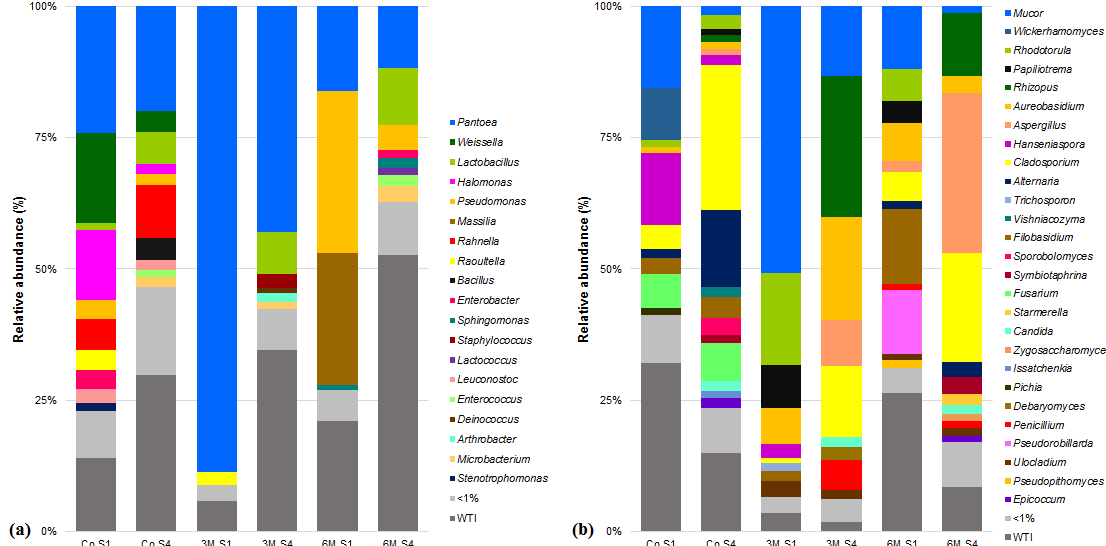
Figure 3. Relative abundances (%) of dominant sequences (>1%) assigned to genus level identified in dried flowers of Cynara cardunculus L. (cardoon) DNA samples based on partial sequence analysis of the ( a ) V3–V4 and ( b ) Internal Transcribed Spacer 2 regions of the rRNA gene. Co refers to the commercially used cardoon by the cheese producer and 3 M and 6 M refers to specific cardoon genotypes. WTI refers to the percentage of sequences without taxonomic attribution to the specified taxonomic level.